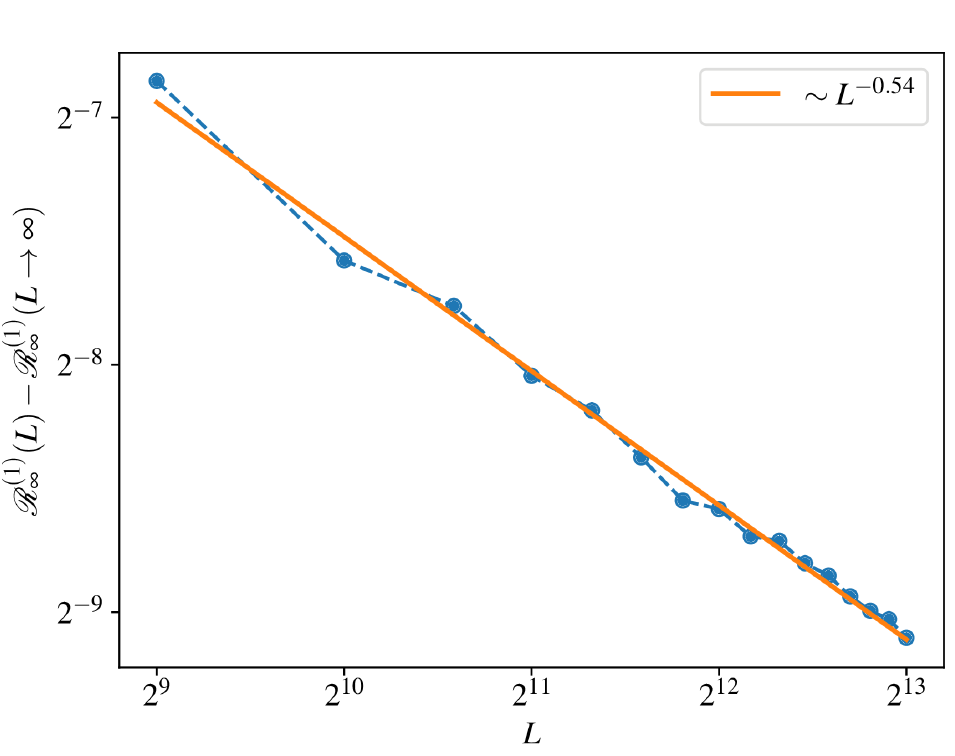
( 1 ) ∞ obtained by subtracting out the leading behavior by